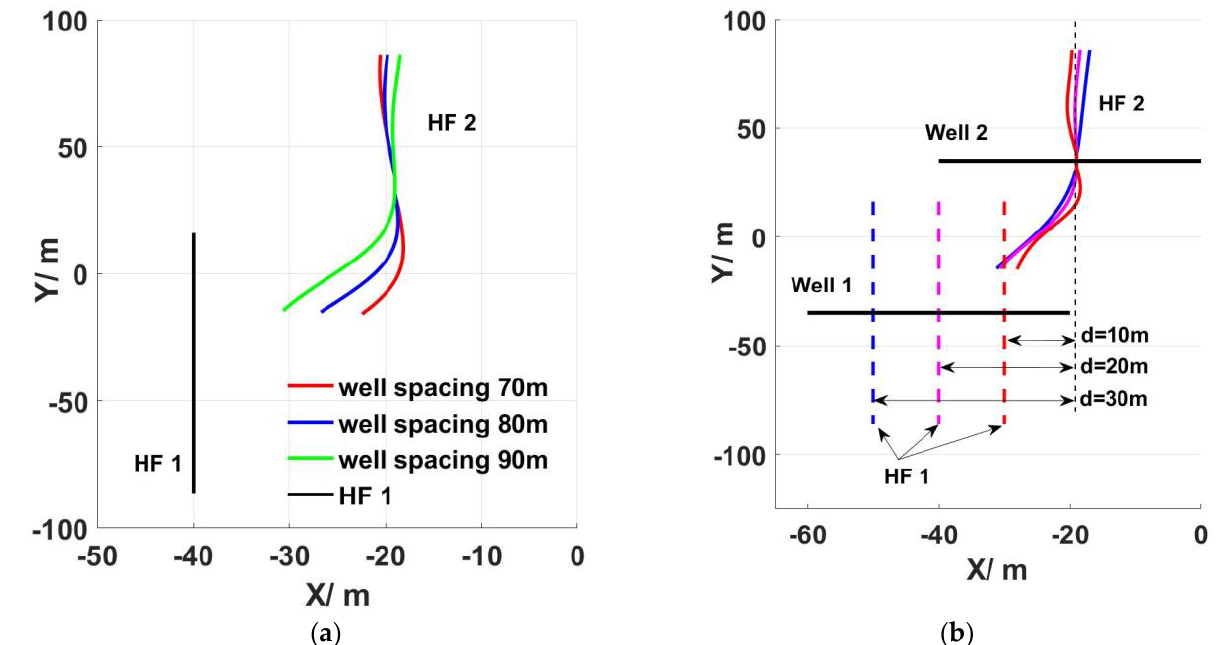
Figure 10. Simulation results of ( a ) the deflection of HF 2 with different well spacing; ( b ) the deflection of HF 2 with different fracture spacing. Where: the solid line on Well 2 represents HF 2 at different fracture spacing. The colors of HF 1 and HF 2 are corresponding at different spacing.